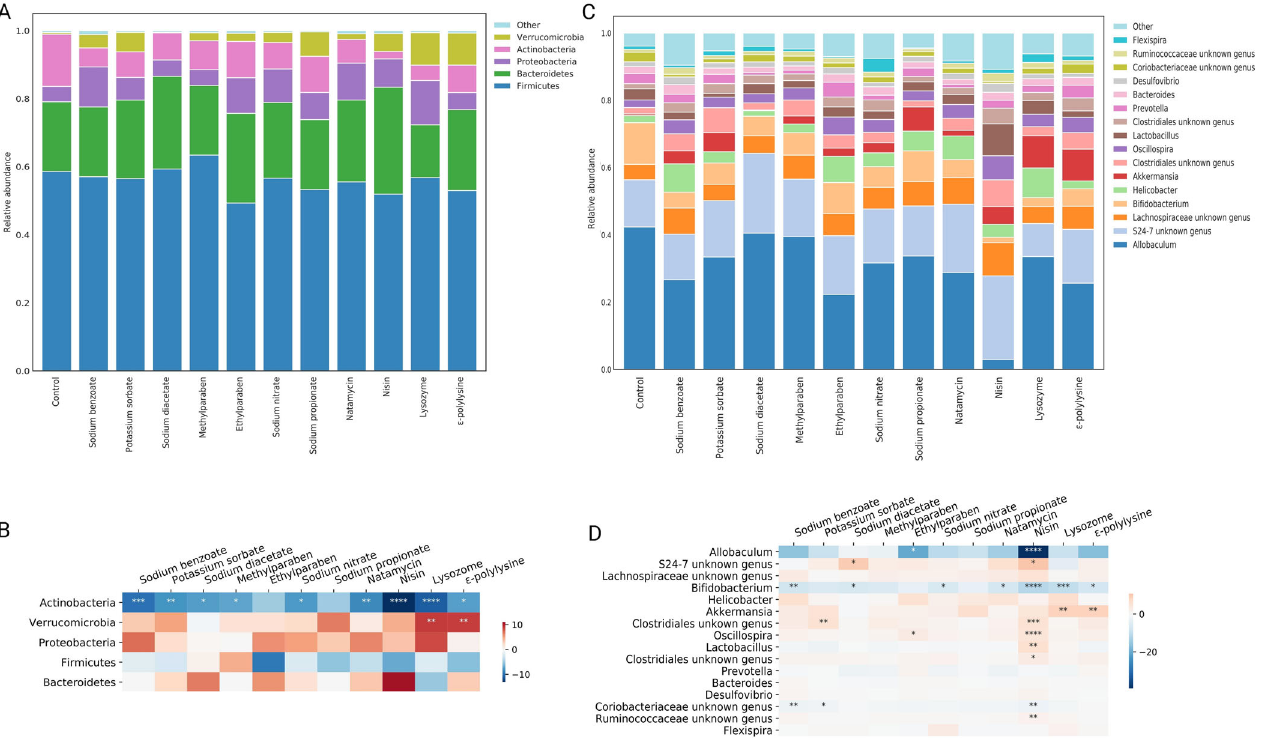
Fig. 3 APs treatment altered microbiota composition at various taxonomic levels. A and C Microbiota composition at the phylum ( A ) and genus level ( C ). B and D Only the fi ve more abundant phyla ( B ) and the 16 more abundant genera ( D ) were represented. Signi fi cance was determined using ANOVA corrected for multiple comparisons with a Dunnett ’ s test. Color coding scale indicates the relative abundance difference between individual AP and control. Grids in red indicate higher relative abundance compared with control, grids in blue indicate lower relative abundance compared with control. n = 9 per group. * P < 0.05, ** P < 0.01, *** P < 0.001, **** P <